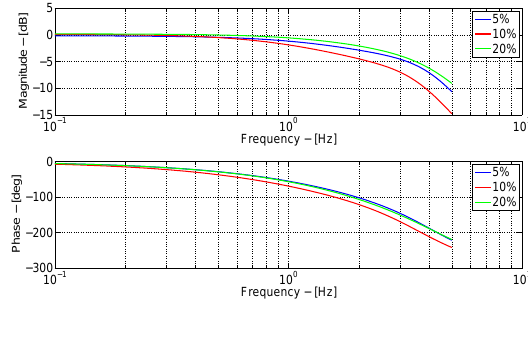
Figure 13: Results at 50% negative offset. The accompanying coefficients describing the three bode plots shown in Figure 13 are given by Table 2. Because b 1 is negative in Tables 1 and 2, it gives that the systems described by these coefficients have a zero in the right-half-plane. A right-half-plane zero pro- duces a +20dB/decade slope on the magnitude,